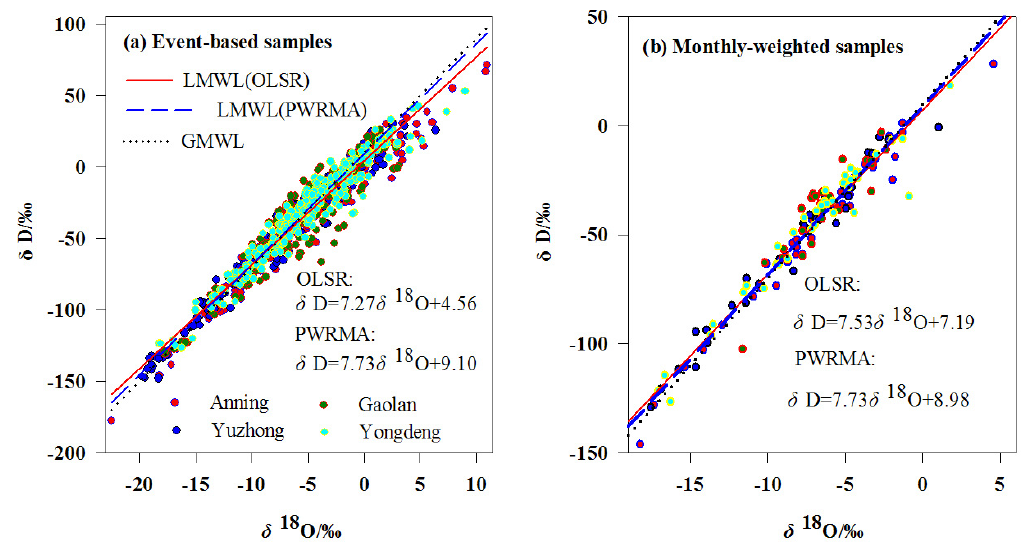
Figure 2. Linear relationship between δ D and δ 18 O using event-based ( a ) and monthly ( b ) data for all sampling stations in Lanzhou from 2011 to 2014. OLSR-based and PWRMA-based LMWLs as well as GMWL ( δ D = 8 δ 18 O + 10; [4]) are shown.